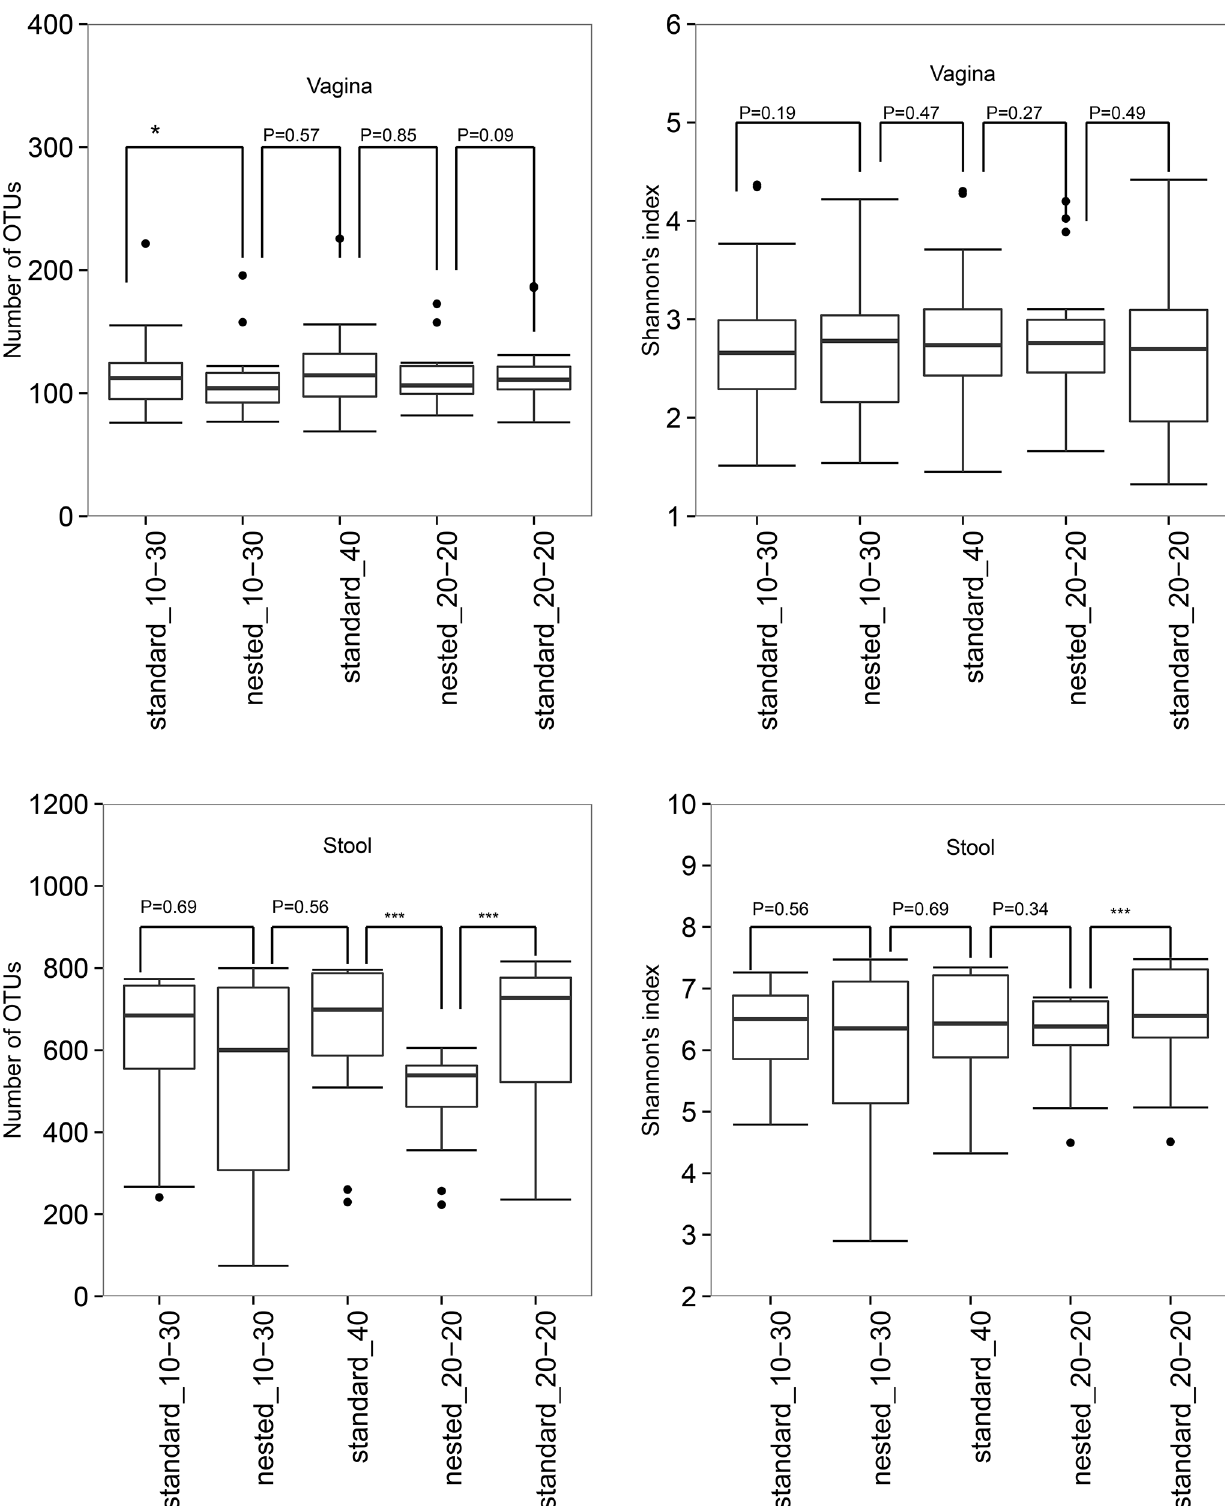
Fig 1. Box plots comparing nested to standard PCRs in number of OTUs and Shannon ’ s index. Note, * P < 0.05, ** P < 0.01, *** P < 0.001, the P values were calculated by the Wilcoxon Matched-Pairs Signed Ranks test.